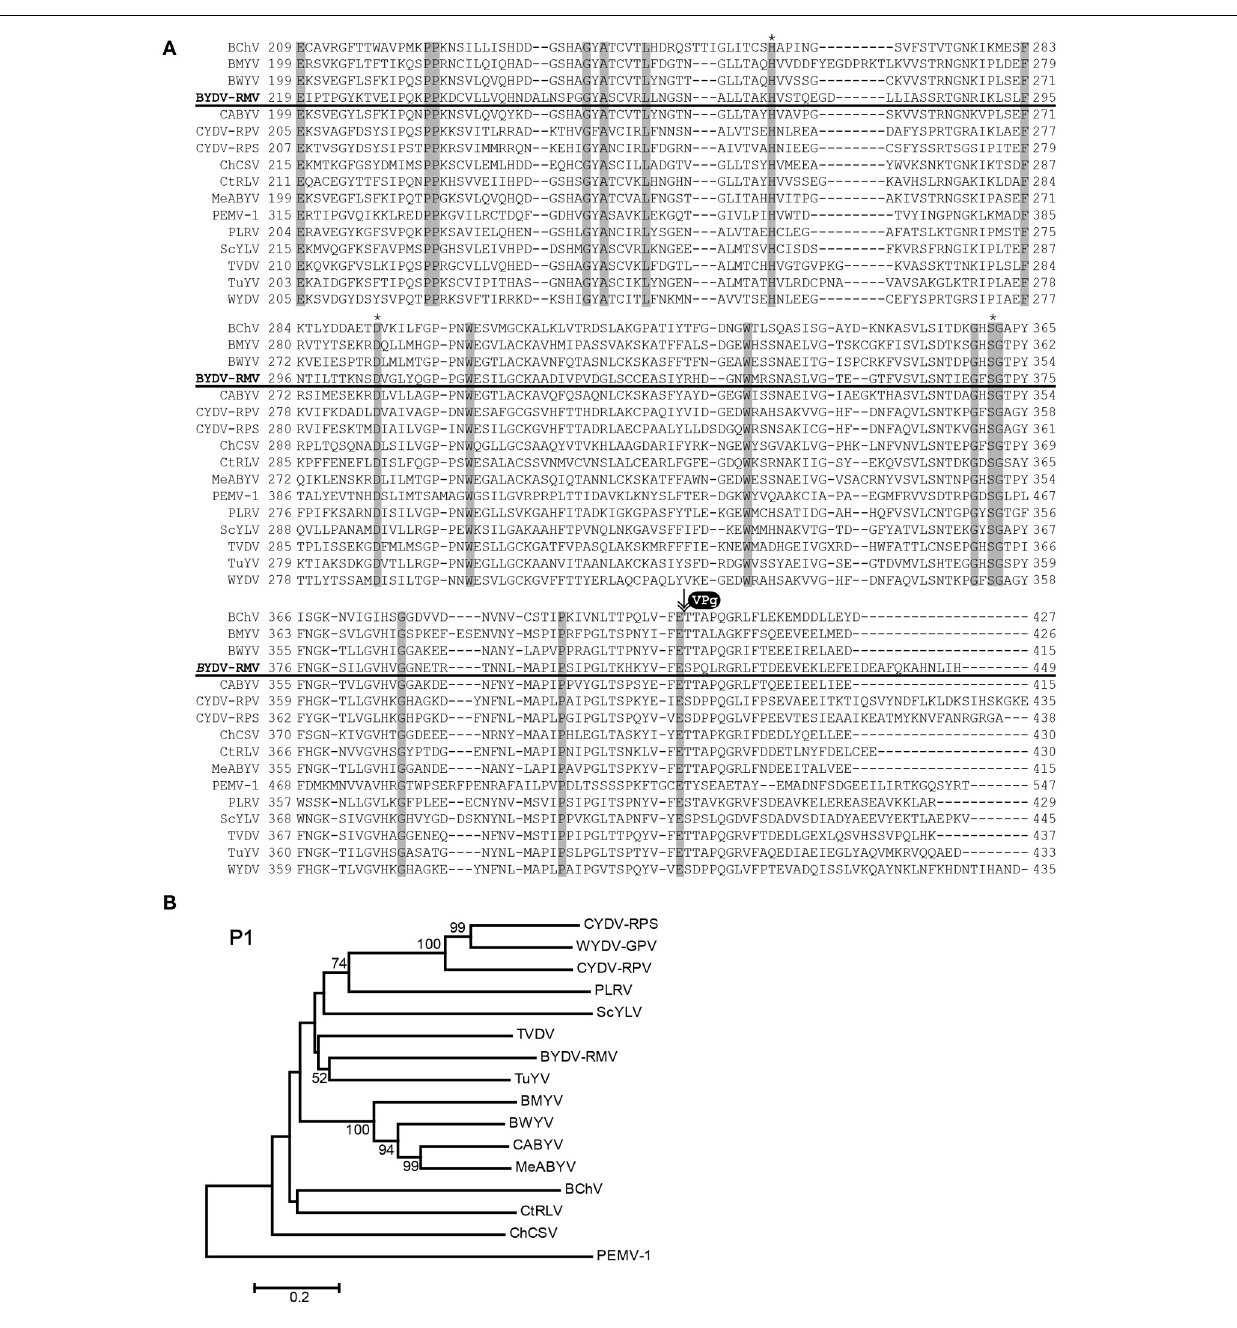
cleavage site that forms the C-terminus of the protease and the N-terminus of the VPg. (B) The MUSCLE aligned P1s for virus in the Polerovirus and Enamovirus genera were used for inferring evolutionary relationships using the Neighbor-Joining method. The resultant tree, drawn to scale, is shown with the percentage (greater than 50% only) of 1000 bootstrap